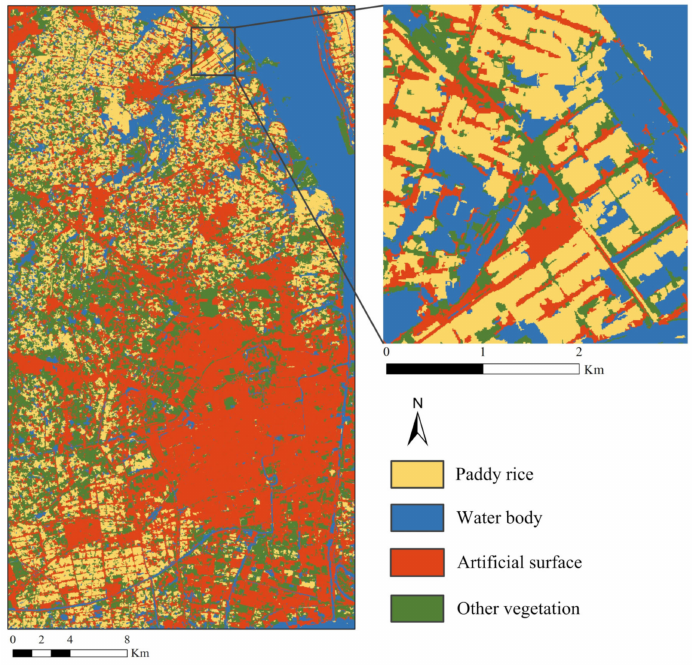
Figure 9. Rice mapping result based on the SOI strategy in 2019.